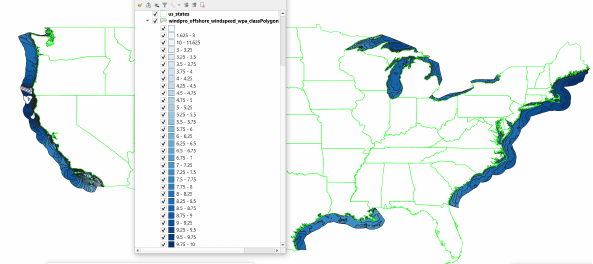
Figure 18. NREL: Wind speed (m/s) in QGIS. Own